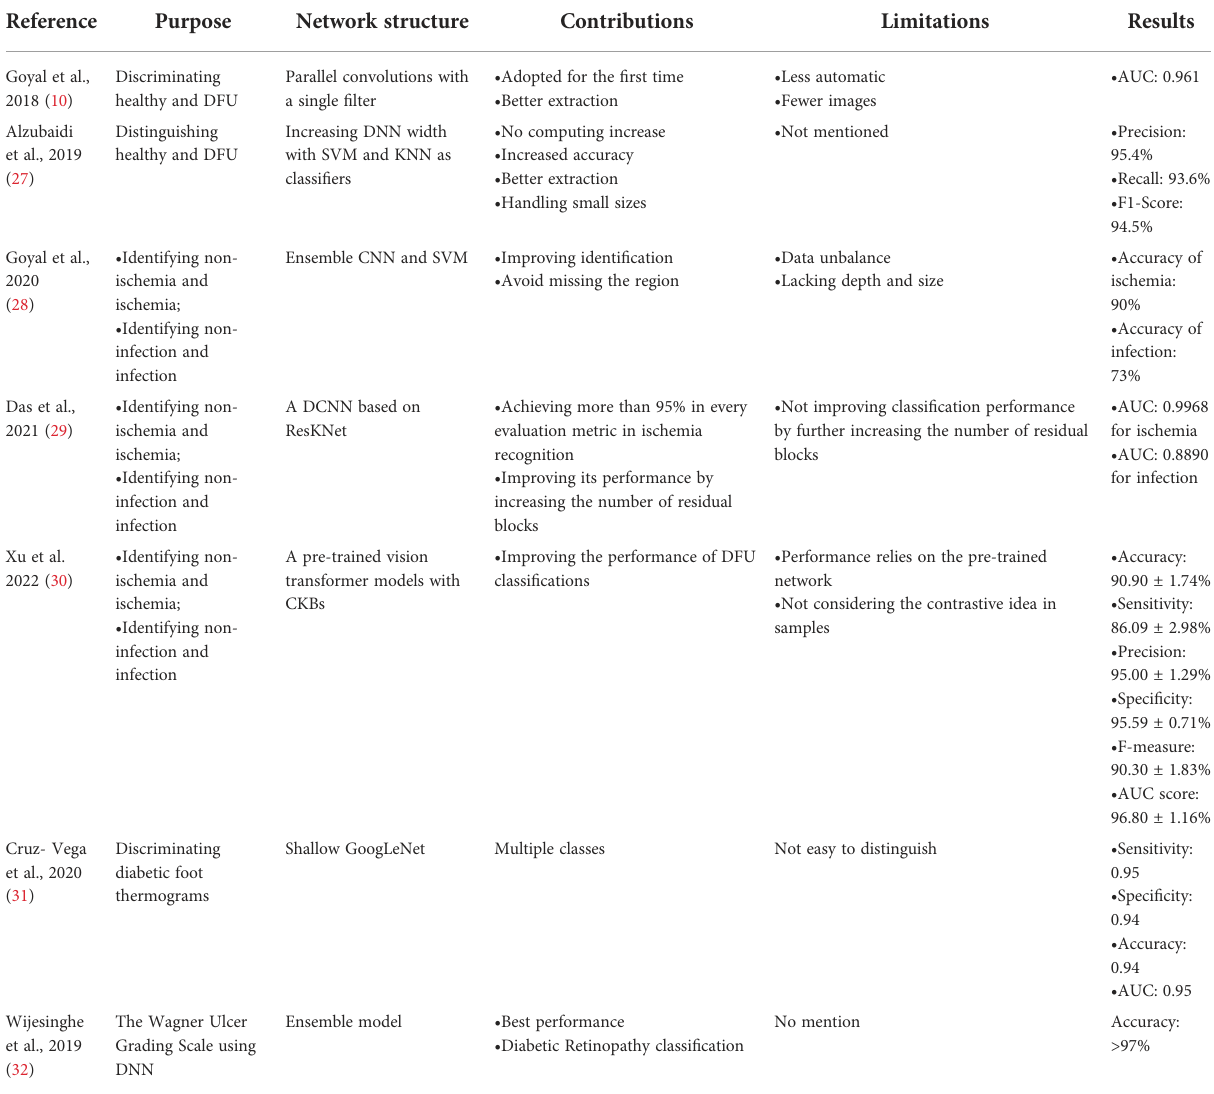
TABLE 1 Summary of deep learning in the classi fi cation for images of diabetes-related foot ulcers.